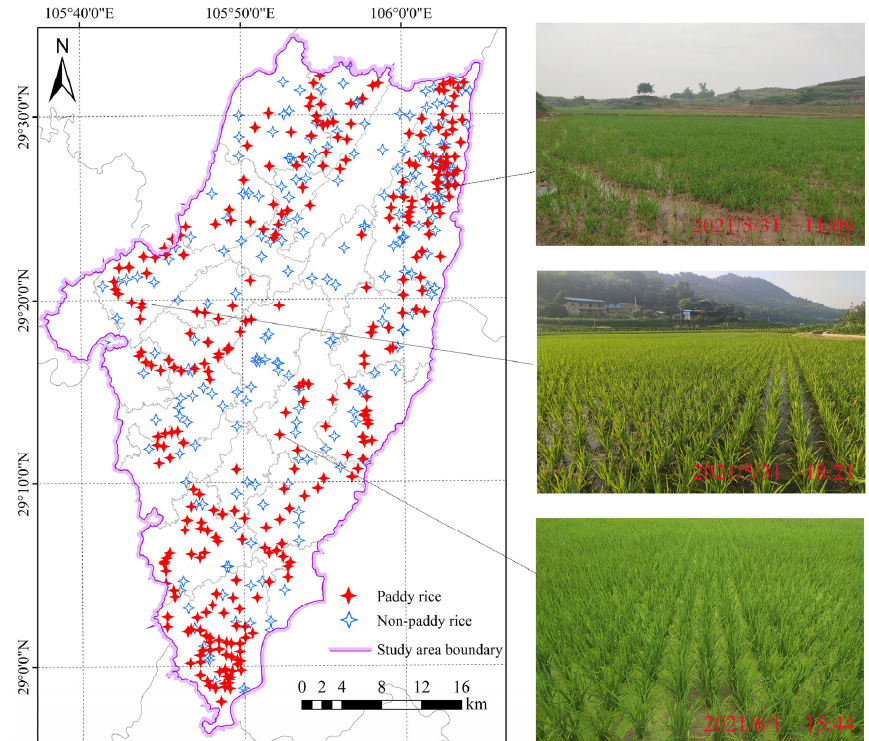
Figure 3. Spatial distribution of field survey data in the study area.